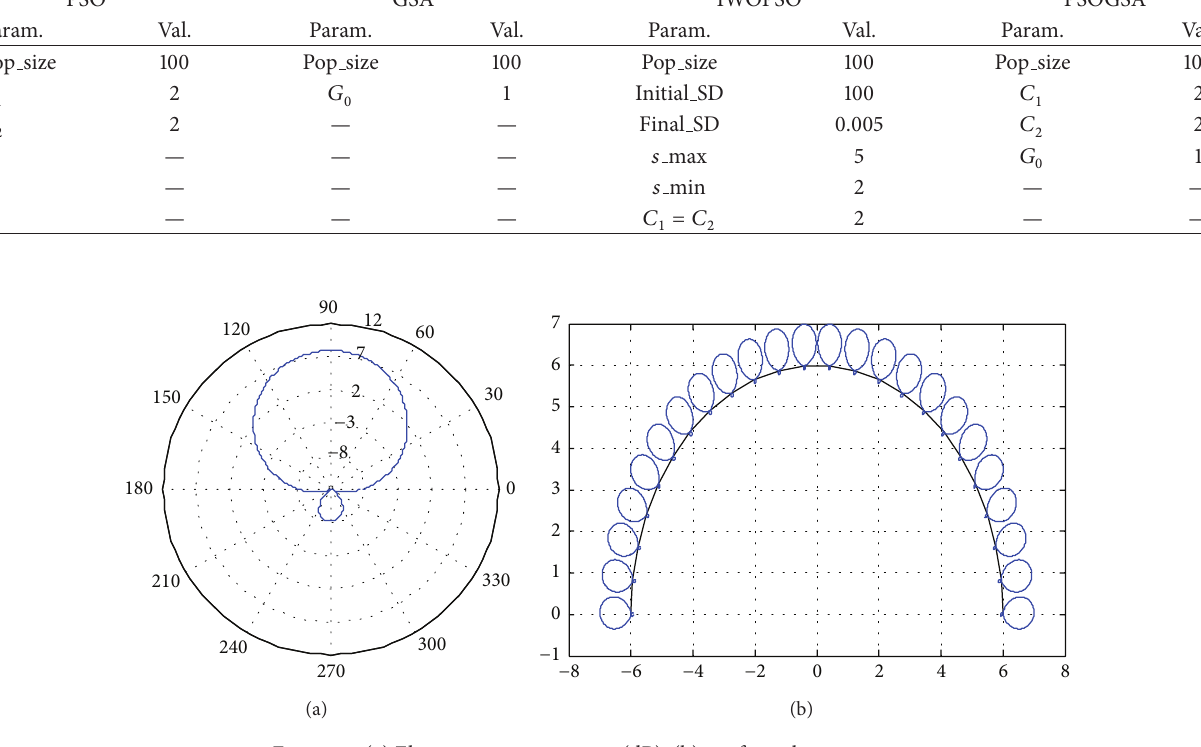
Figure 5: (a) Element antenna pattern (dB). (b) conformal array pattern.